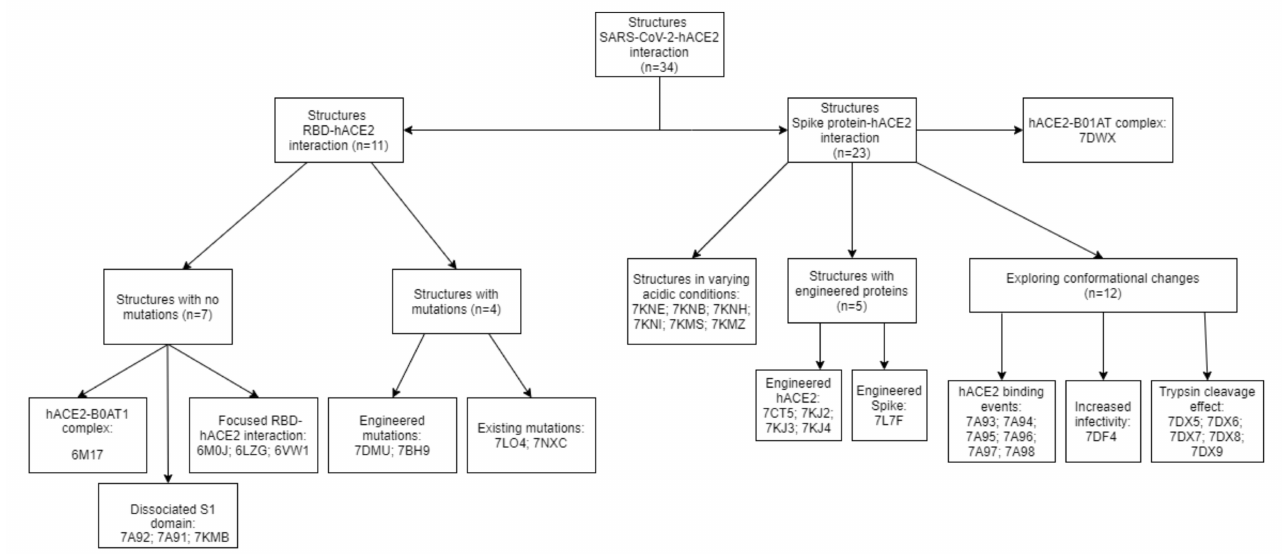
Figure 4. Organizational scheme of all structures found in this review. Molecular graphics analyses were performed with UCSF Chimera and Visual molecular dynamics [29,33]. A homology model for the S protein of SARS-CoV-2 Delta variant was created using SWISS-MODEL [37].